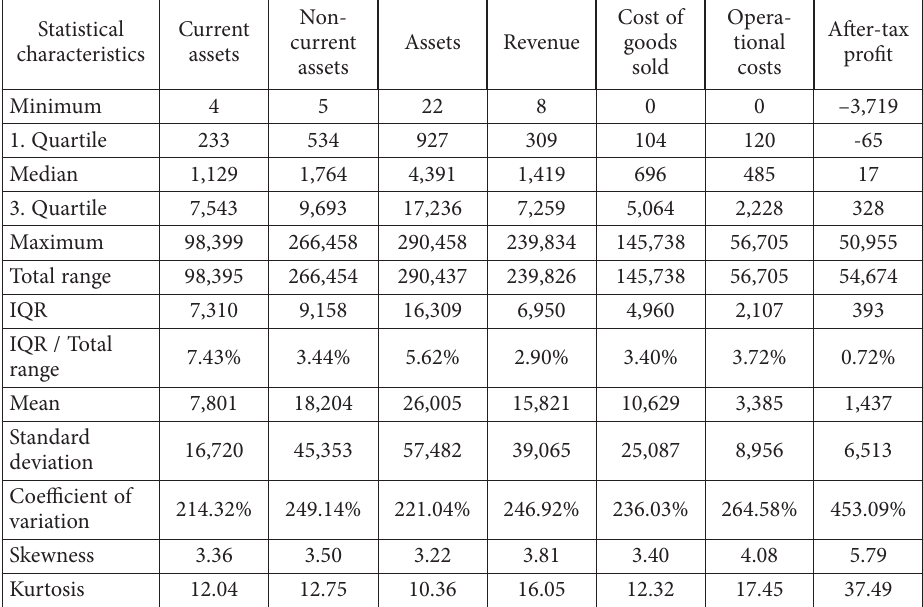
Table 1. Descriptive statistics of variables investigated (source: own calculation by R Studio (average of 4 years)) (million